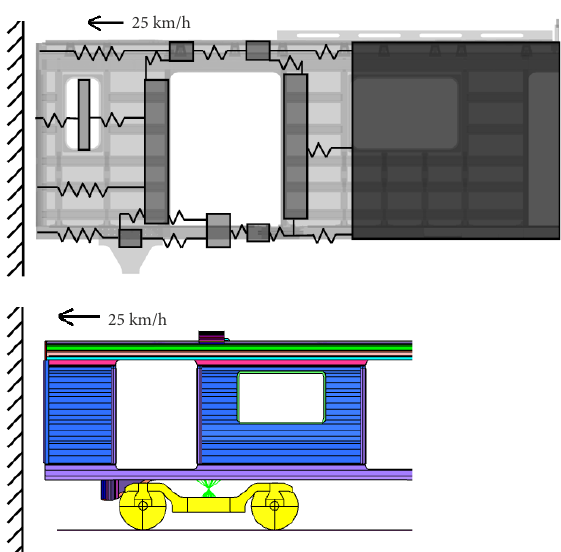
Figure 24. Lumped parameter model of frontal impact and FE model of type C